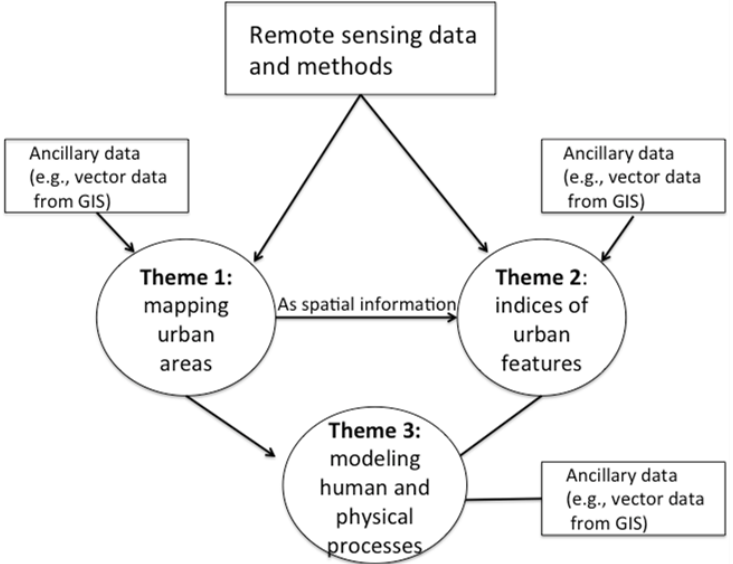
Figure 1. The three themes of the literature review are interrelated and form the basic structure to describe how remote sensing data and methods support research in global environmental